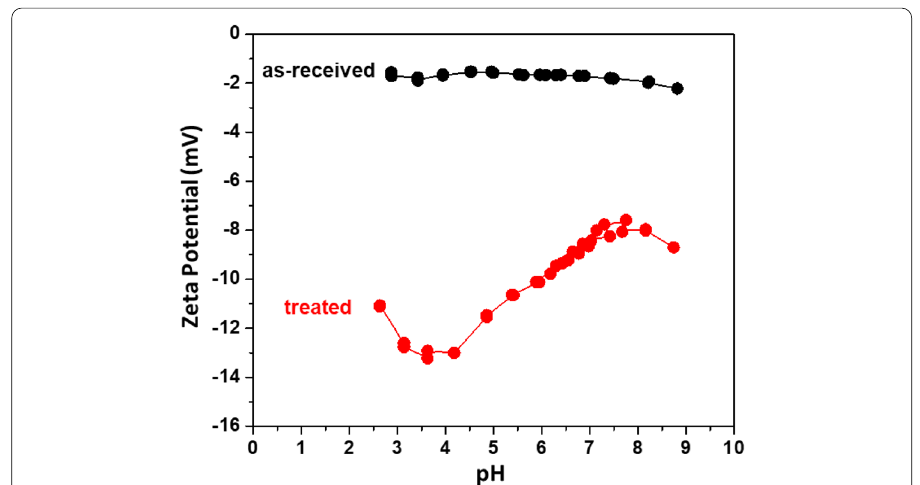
Fig. 2 Zeta potential of source and treated muslin samples as a function of pH (data courtesy of E. Lam, Anton‑Paar USA)